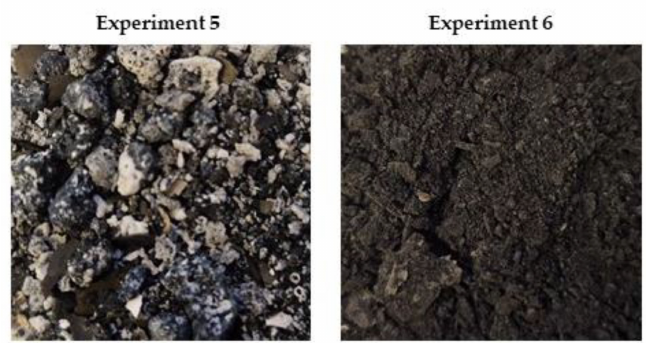
Figure 10. Solid sample from SCWG reactor in experiment 5 and experiment